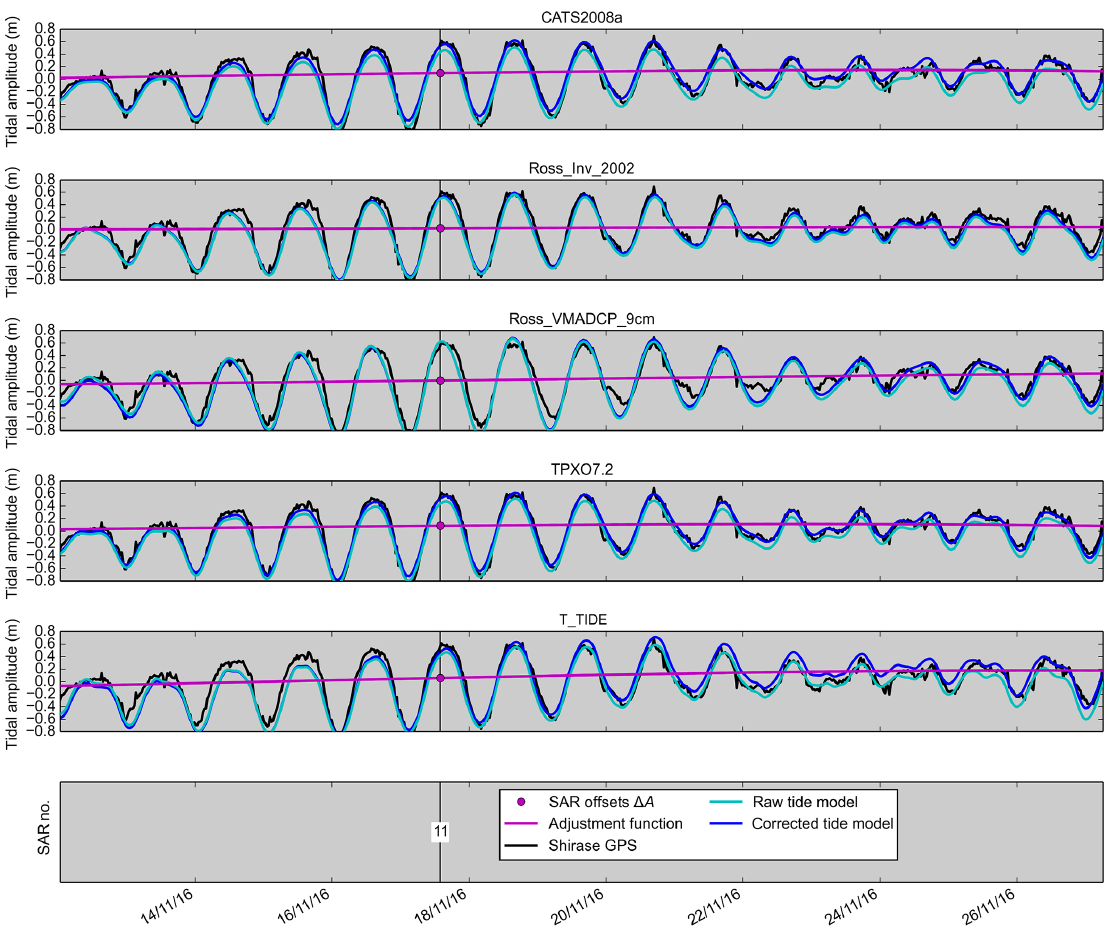
Figure A1. Validation of the tidal predictions of five tide models with a GPS record from the freely floating Shirase station. The tide-model outputs are adjusted to match DInSAR observations using a least-squares fitting technique published by Wild et al. (2018). Root-mean-square errors before and after this adjustment are presented in Table A1. The length of the records corresponds to the grey-shaded area in Fig. 4.